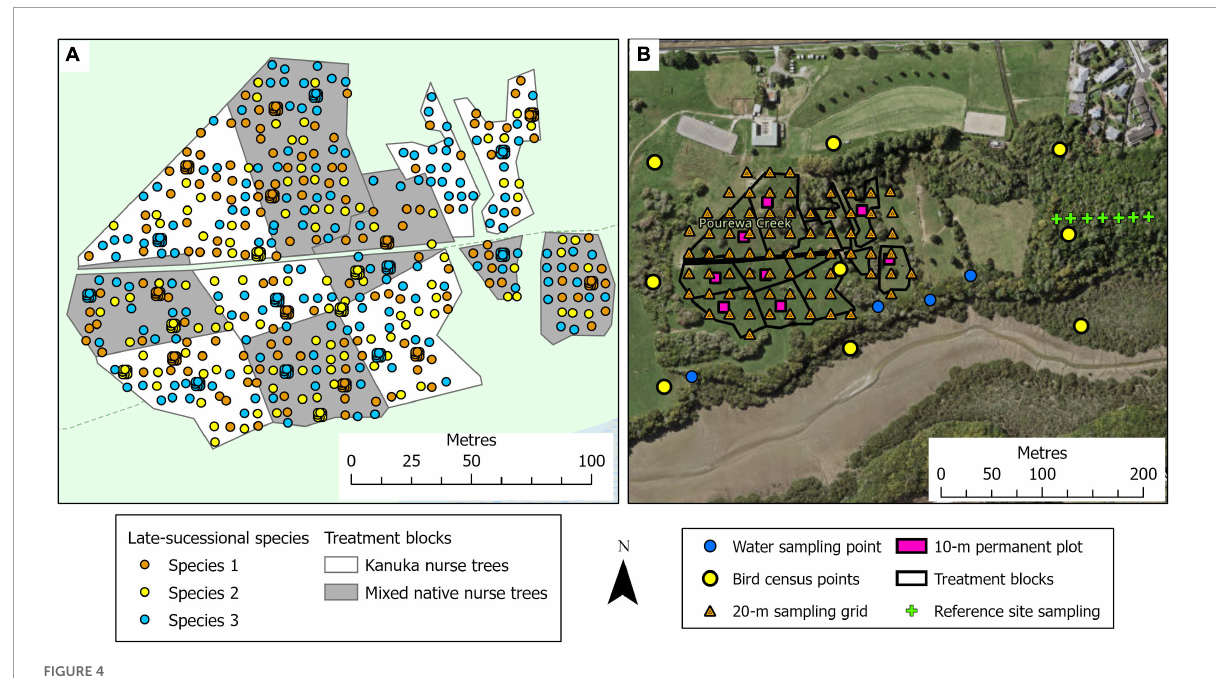
FIGURE4 Illustration of the tree planting, treatment block, and site monitoring design for the Pourewa experimental site. (A) The treatments involve two types of nurse tree compositions: k¯anuka and mixed-native species, all planted at a 1.5-m spacing; across the site, late-successional canopy species are planted singly at a 6-m spacing, and in clusters of nine seedlings 1-m apart, in a randomized design (see Tables 1 , 2 ). Survival and performance of both target and nurse tree species are monitored through time. (B) Monitoring design, at the landscape scale (e.g., bird observations, water quality), at the treatment block scale, within 10 × 10-m permanent plots (e.g., decomposition, natural seedling recruitment), and at the 20-m sampling grid scale (e.g., soil chemistry, soil